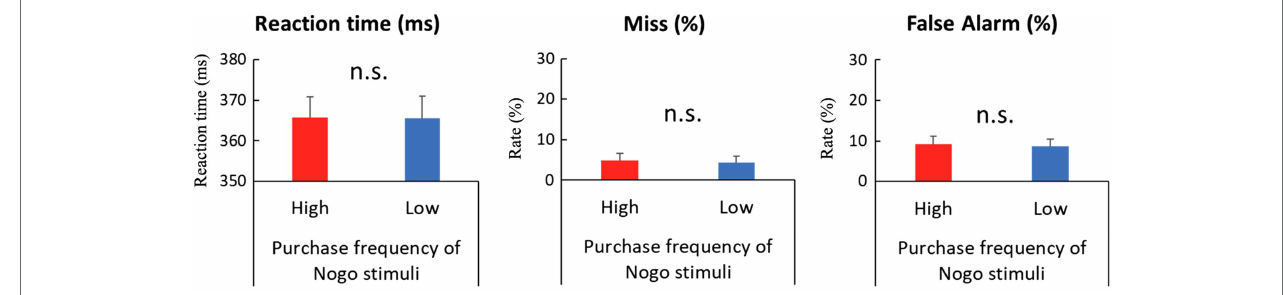
FIGURE 2 | Comparisons of behavioral performance between high and low purchase frequency of No-go stimuli in Go/No-go task. Left: Reaction time of Go trial. Middle: Miss rate of Go trial. Right: False alarm rate of No-go trial. Error bars in all panels represent standard error of the mean. None of the differences were significant. n.s. = not significant.